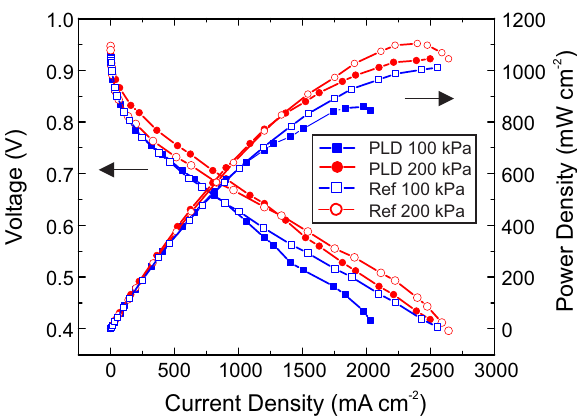
Figure 8. J-V and power density curves of a PEM fuel cell having both electrodes prepared by PLD with an anode Pt loading of 17 µ g · cm − 2 and a cathode Pt loading of 100 µ g · cm − 2 for various outlet